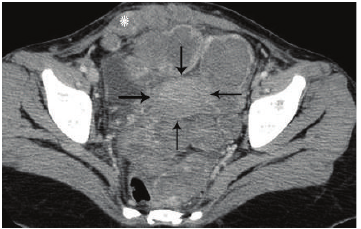
Figure 8: Choriocarcinoma in a 23-year-old patient who presented 2 years after a normal pregnancy with abdominal distension and markedly raised 𝛽 -hCG levels. Axial contrast enhanced CT image of the pelvis reveals extensive, heterogeneously enhancing extrauterine tumor deposits in the pelvis involving pouch of Douglas, left parametrium, anterior peritoneum, and both recti (asterisk). Uterus is marked with black arrows.